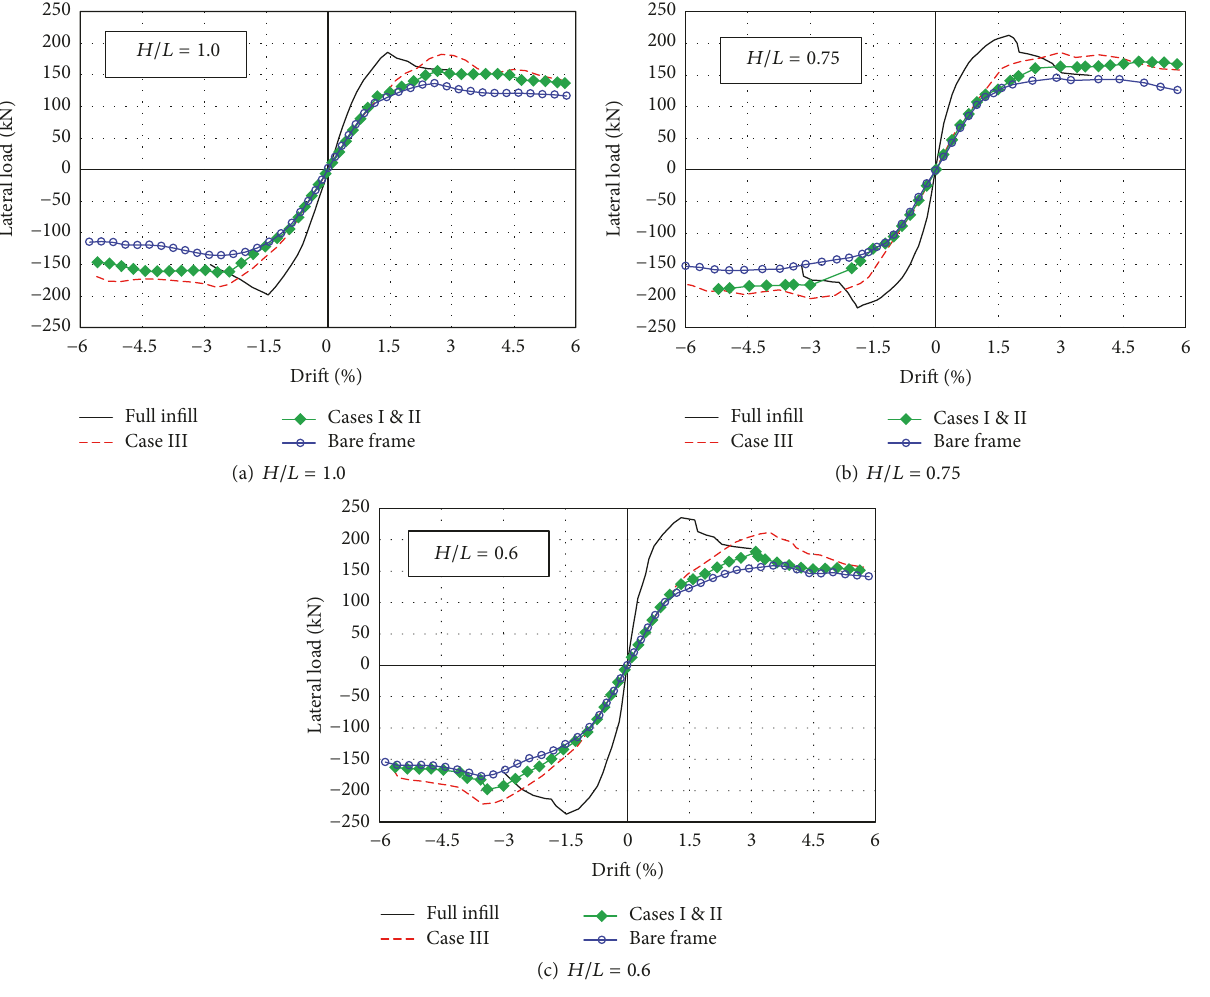
Figure 9: Cyclic response of infilled frames subjected to in-plane